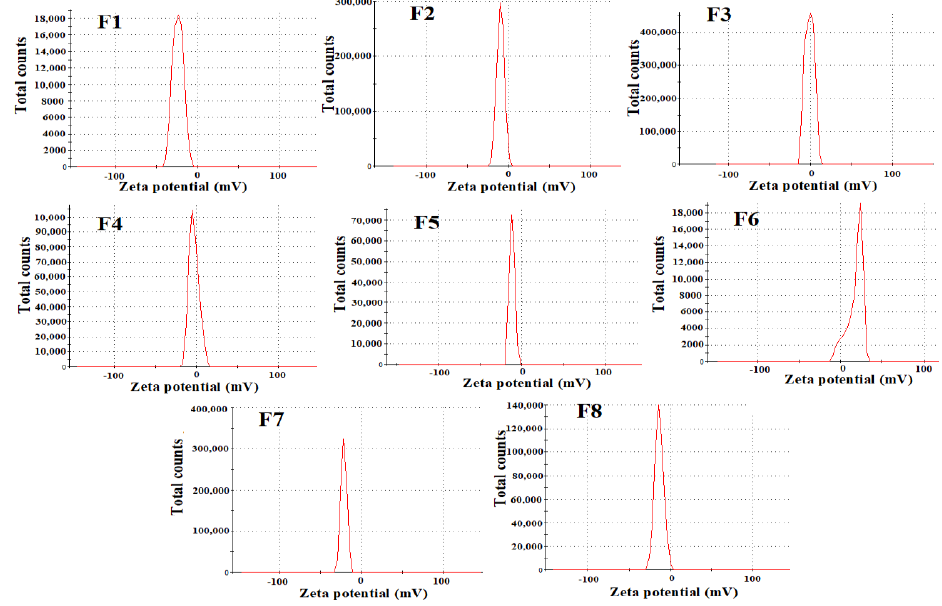
Figure 1. Zeta potentials of prepared LC-CS nanoparticles. Overall, both F1 and F3 showed the highest desirability, yielding the same value of 0.5511 (Table 3). They were followed by F2 (0.5506), F4 (0.5410), F7 (0.4967), F5